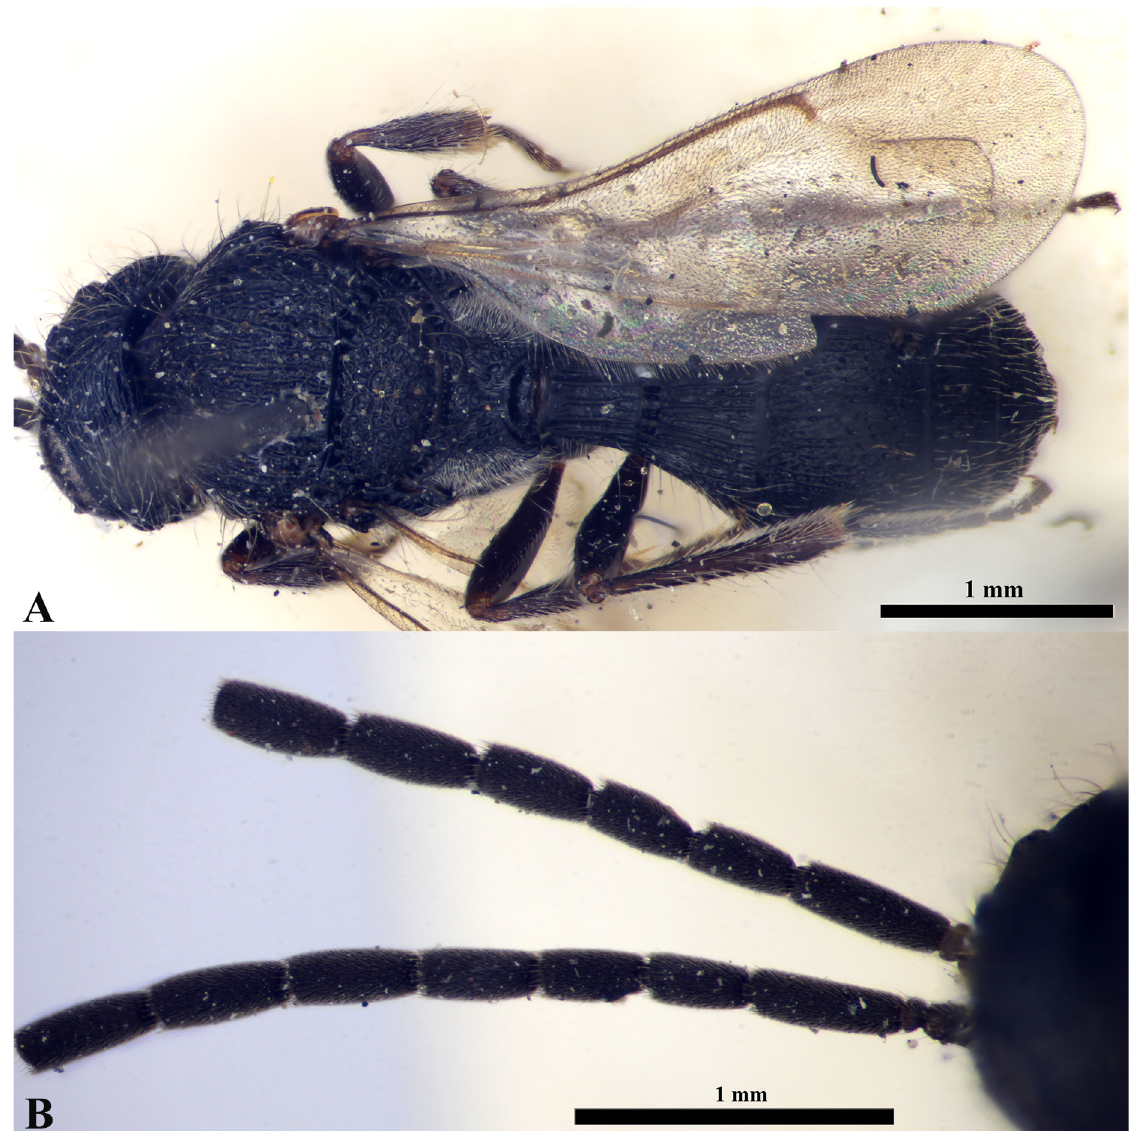
Fig. 15. Odontoscelio pluto (Nixon, 1936). Syntype, ♂ (NHMUK 013379414). A . Habitus, dorsal view. B . Antennae. Photos: D.G. Notton © ,